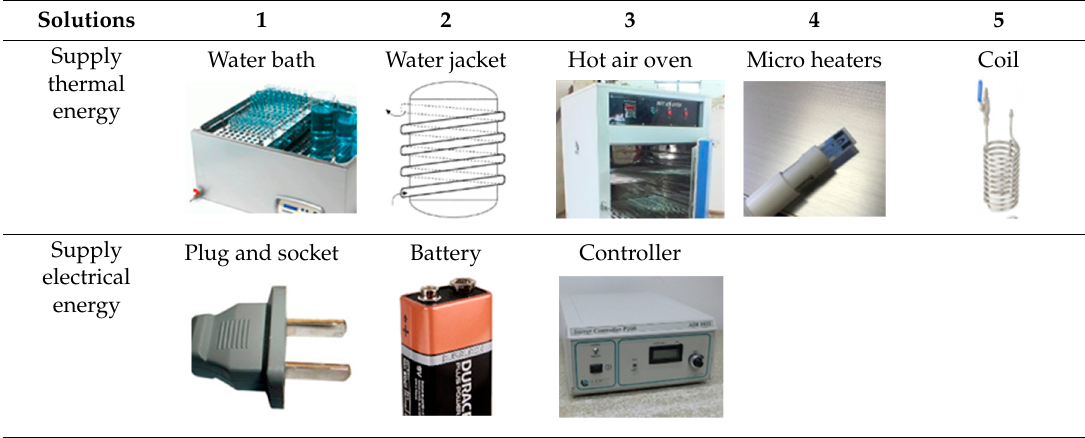
Table 2. Morphological overview within the first column, the subfunctions with multiple suitable solutions and in the remaining columns the di ff erent solutions.